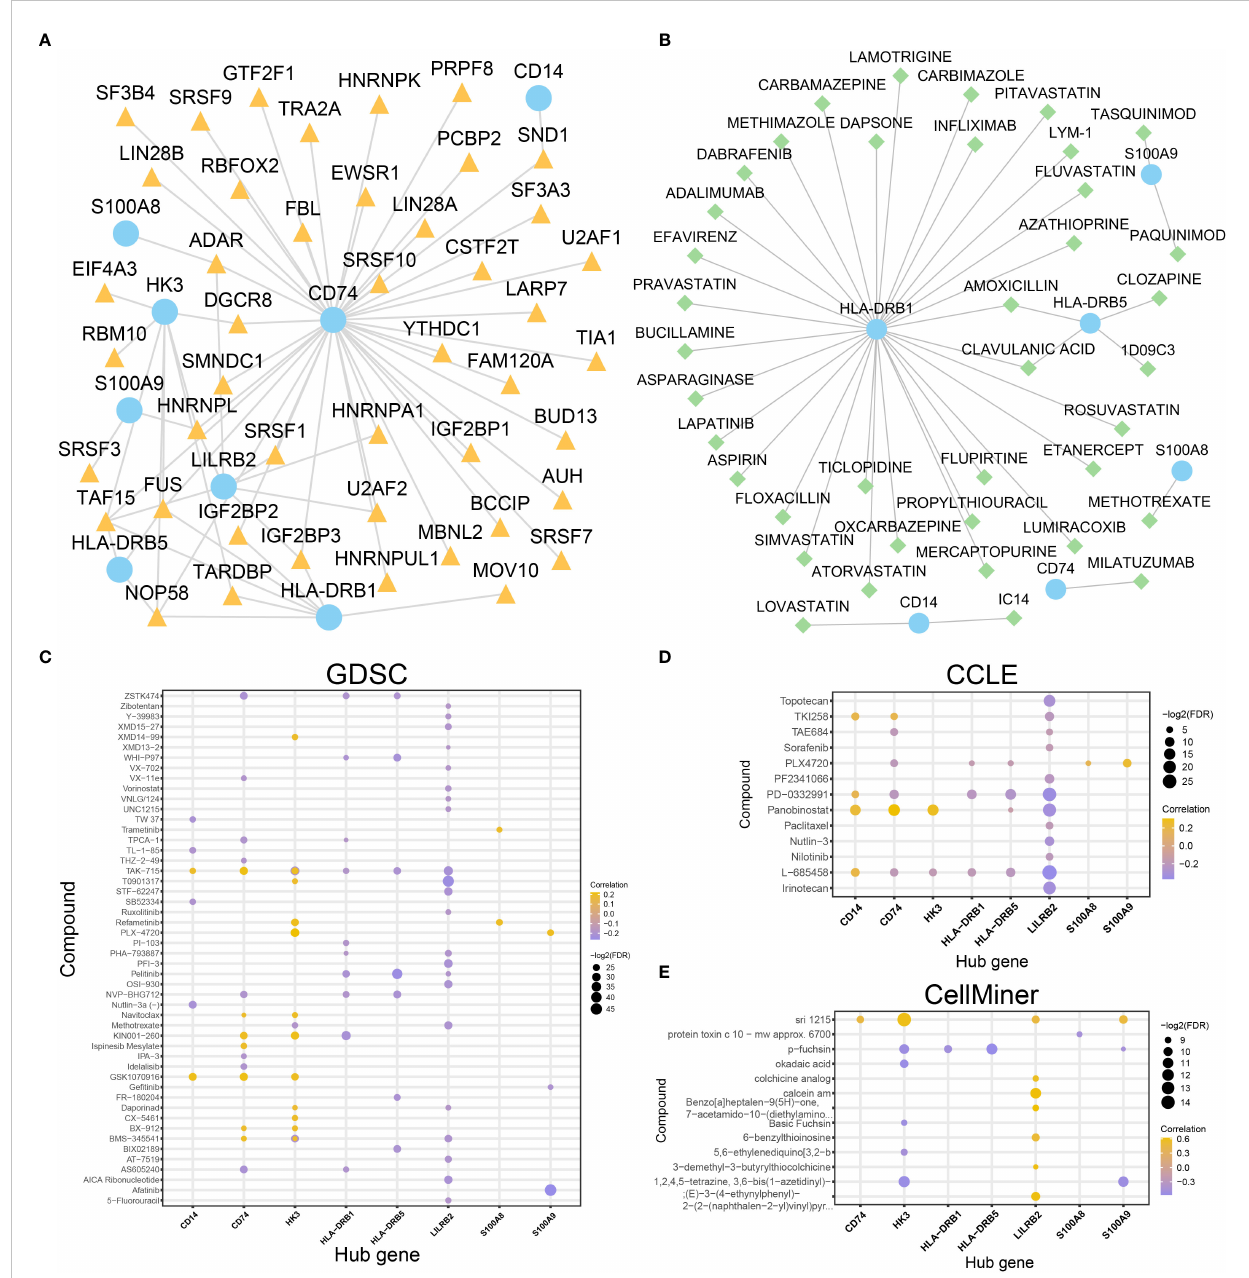
FIGURE 11 Construction of mRNA-RBP and mRNA-drugs interaction network and drug sensitivity analysis. (A, B) . mRNA-RBP (A) and mRNA-drugs (B) interaction networks for the identi fi ed hub genes. (C – E) . Drug sensitivity analysis results of hub genes in the GDSC database (C) , CCLE database (D) , and CellMiner database (E) . In the mRNA-RBP interaction network (A) , the blue circular block is mRNA; the orange triangle block is RBP. In the mRNA-drugs interaction network (B) , the blue circular block is mRNA; the light green diamond block is